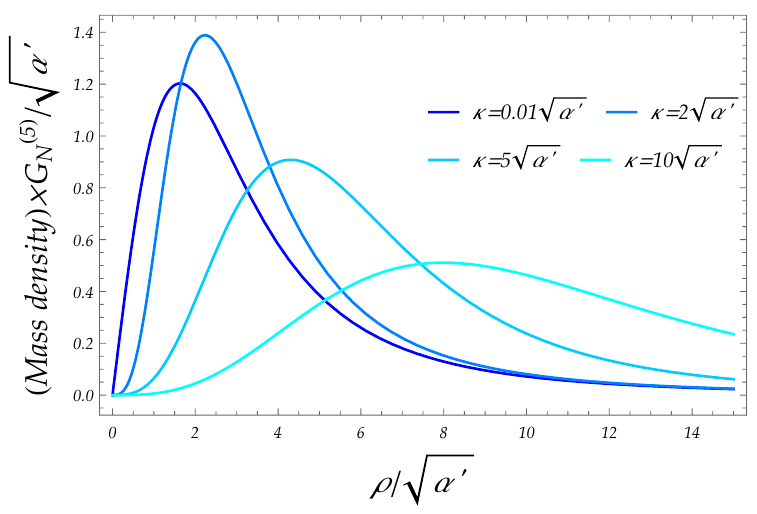
Figure 1 . Radial mass density function of the global instanton solution for di(cid:11)erent values of the instanton scale, (cid:20) 2